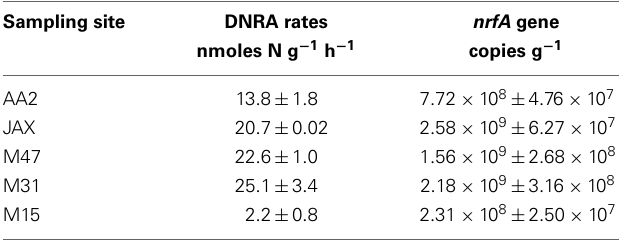
Table 2 | Potential rates of DNRA and nrfA gene abundance in the five sediment communities of the New River Estuary.